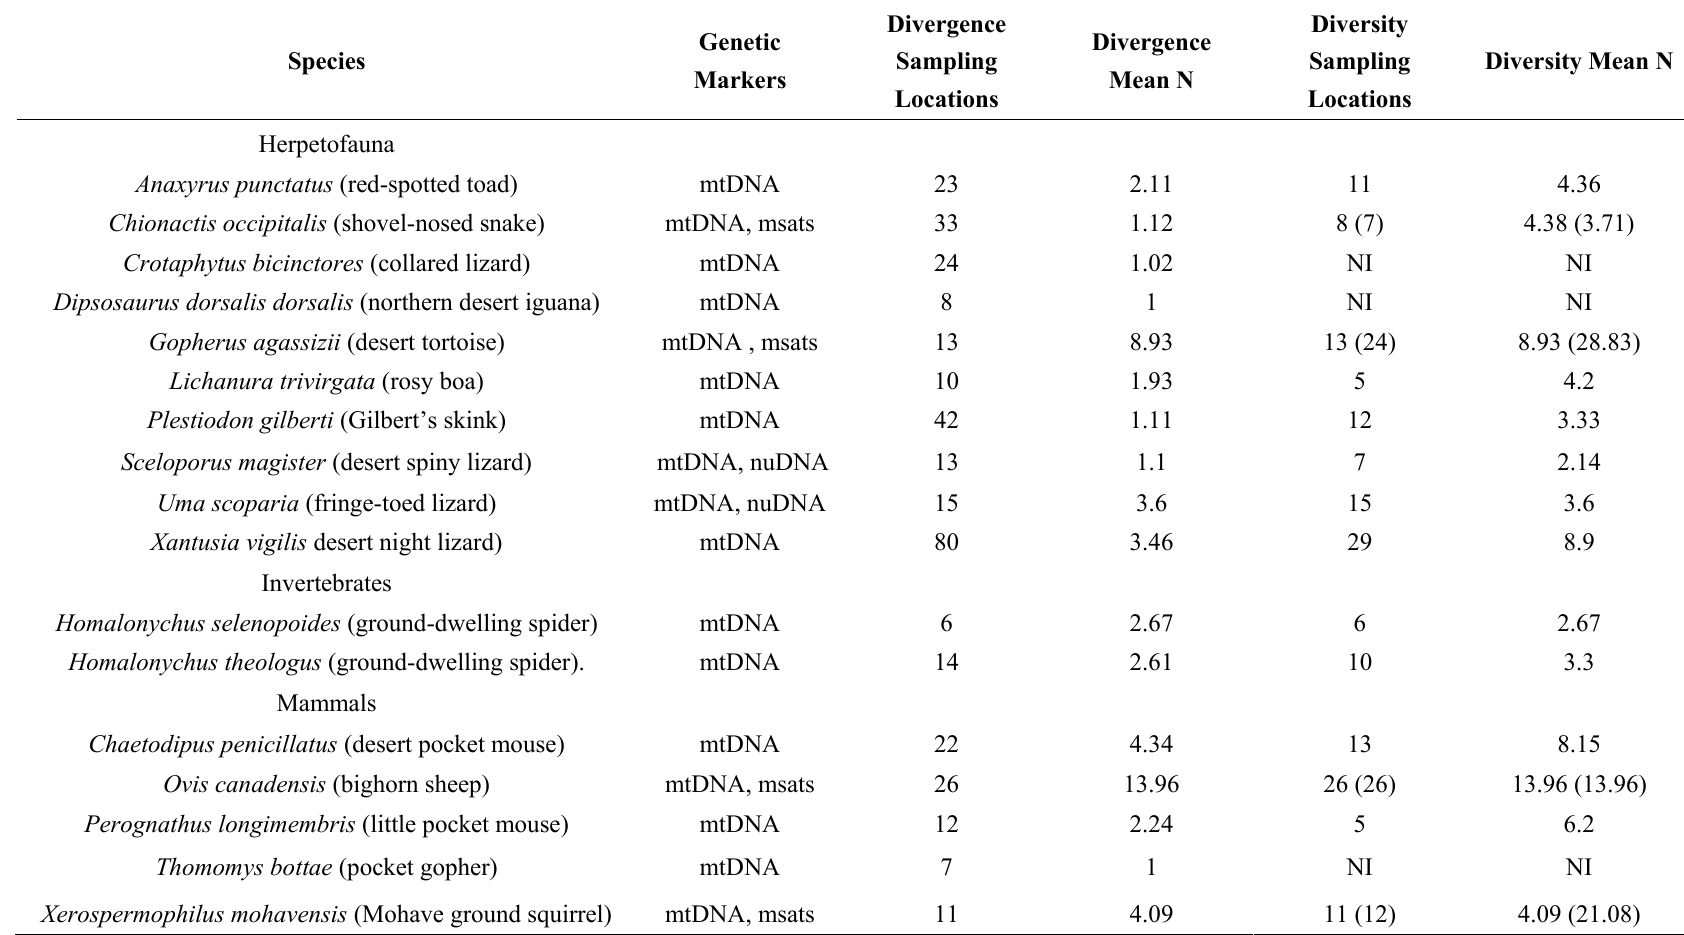
Table 1. Species and genetic datasets examined. The number of sampling locations within the study region and mean number of individuals sampled per location are given for divergence and diversity estimates. Numbers for gene diversity estimates based on microsatellite markers are provided in parentheses. NI denotes not